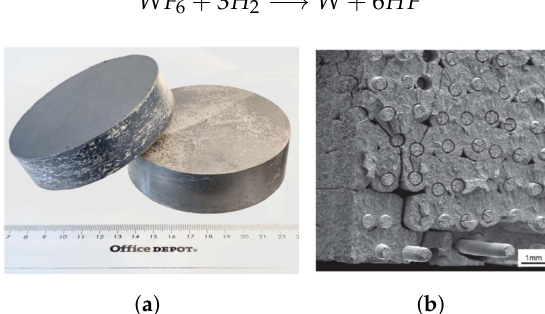
Figure 7. ( a ) PM W f /W prototype ( b ) typical fracture surface of CVD W f /W. Reprinted with permission from Ref. [29]. Credit c (cid:13) IOP Publishing,